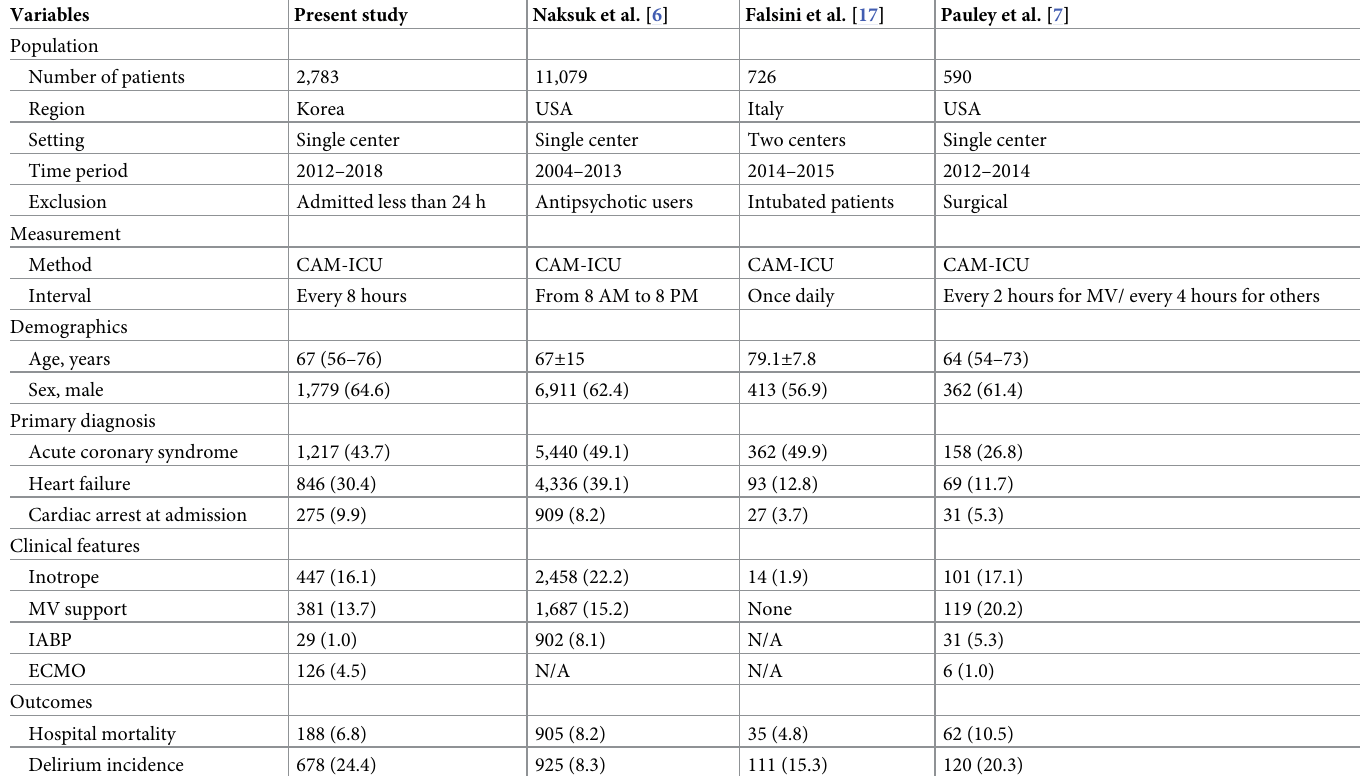
Table 2. Characteristics of patients in present study compared with other CICU delirium